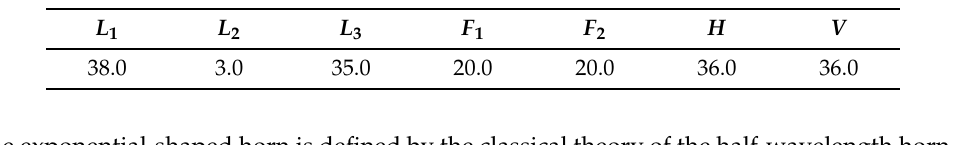
Table 2. Initial values of the stator’s main parameters